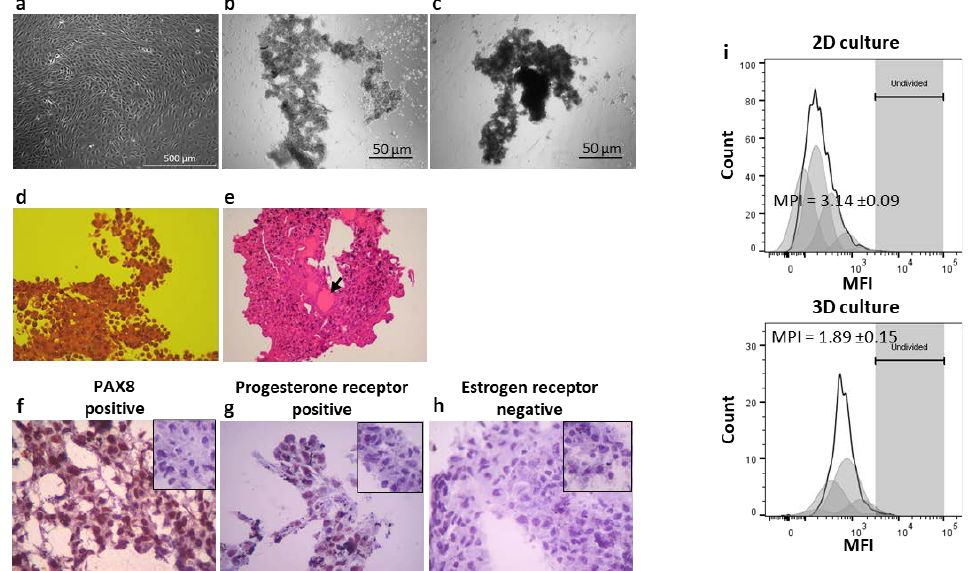
Figure 1. Analysis of morphological and histological features of the CAISMOV24 cells in 3D culture. Phase contrast microscopy of CAISMOV24 cells growing as ( a ) monolayer in 2D culture or growing as cell aggregates in 3D culture at ( b ) 24 h and ( c ) at 72 h. ( d and e ) Brightfield microscopy of histological cuts representative of CAISMOV24 cell aggregates ( n = 8); ( d ) Histological cut showing papillary morphology of the cell aggregate (obj. 40×; H&E staining) and ( e ) the presence of focal acinar arrangement with secreted material (arrow; obj. 10×; H&E staining). Immunohistochemistry analysis of cryosections of 3D-cultured CAISMOV24 cells ( n = 6 cell aggregates) showing nuclear expression of PAX8 ( f ) and progesterone receptor ( g ) in brown, as well as, absence of estrogen receptor ( h ) compared with their respective negative controls (insets); cells are counterstained with hematoxylin. ( i ) Proliferation profile of CAISMOV24 cells assessed by flow cytometry on day 5, following cell labeling with violet proliferation dye 450 (VPD450); shaded areas represent each of the new cell generations, which retained approximately half of the VPD450 fluorescence intensity of their parent cells. The mean proliferation index of CAISMOV24 cells was significant lower ( p < 0.0001, t-student test) in 3D culture ( n = 7 experimental repetitions) than in the 2D culture ( n = 3). MPI = mean proliferation index.